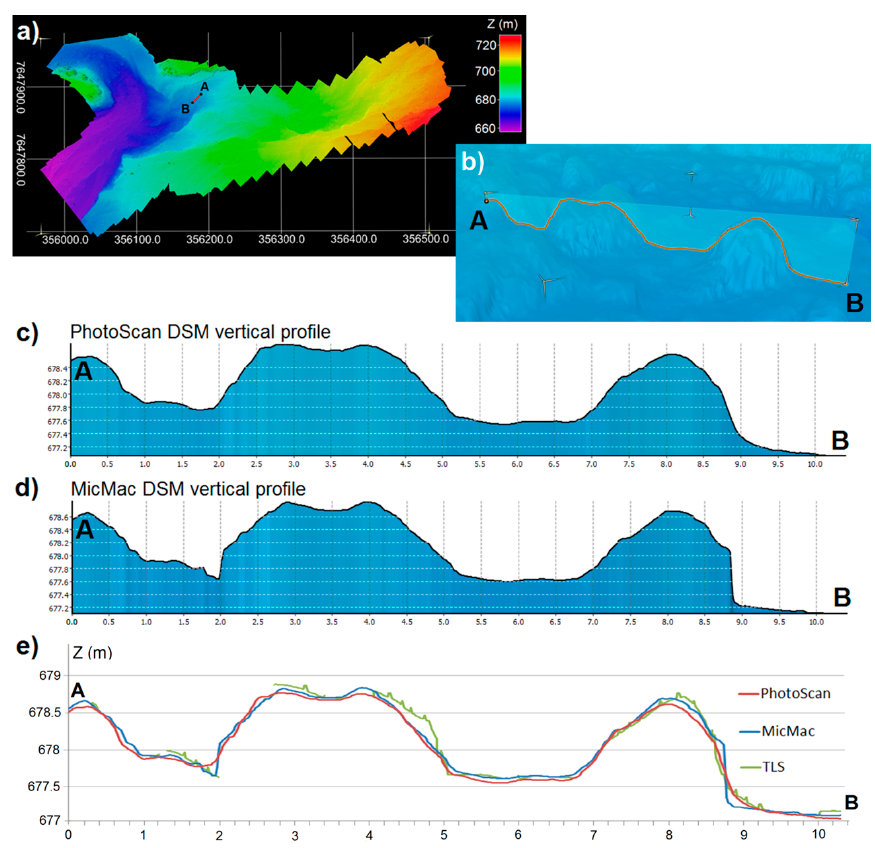
Figure 10. ( a ) Location map of the selected profile on the PhotoScan DSM of the study area; ( b ) 3D view (on PhotoScan DSM) of the profile over a set of blocks of rocks; ( c , d ) Vertical profiles extracted from PhotoScan DSM ( c ) and MicMac DSM ( d ); ( e ) Comparison of profiles extracted from PhotoScan DSM, MicMac DSM and TLS point cloud.